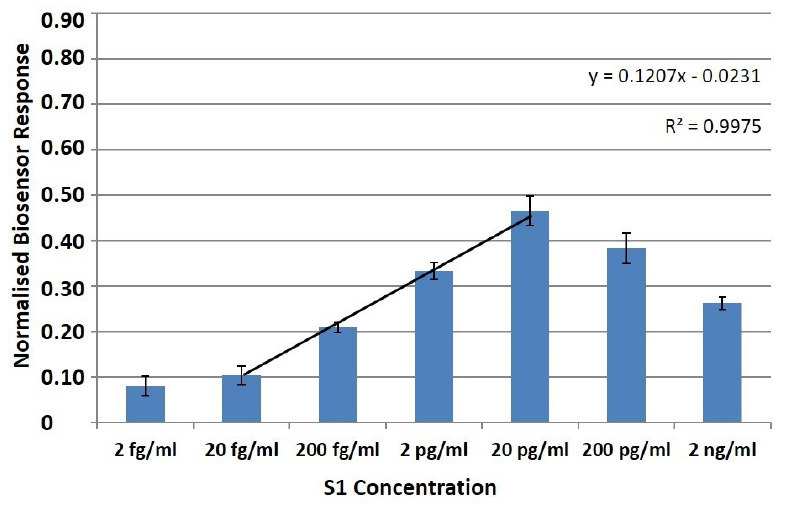
Figure 4. Normalized (vs. control) 3D immobilized cell biosensor’s response to the SARS-CoV-2 spike S1 protein. SK-N-SH/anti-S1 cells membrane engineered with 0.5 µ g/mL of human monoclonal antibodies, were used as the biorecognition element. Results are presented after three minutes (columns) of sample–cell interaction. Results are expressed as normalized biosensor responses ([control–sample response]/control, n =